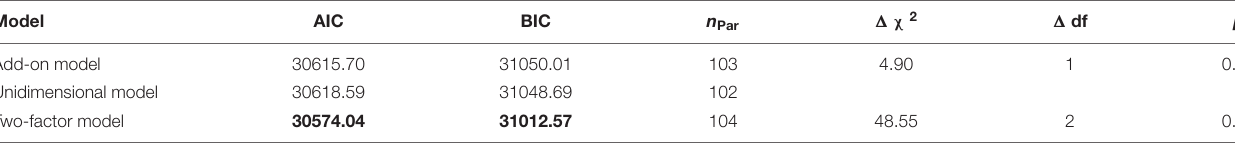
TABLE 4 | Structural analysis of STC and MDC test items and model comparison with the unidimensional model.